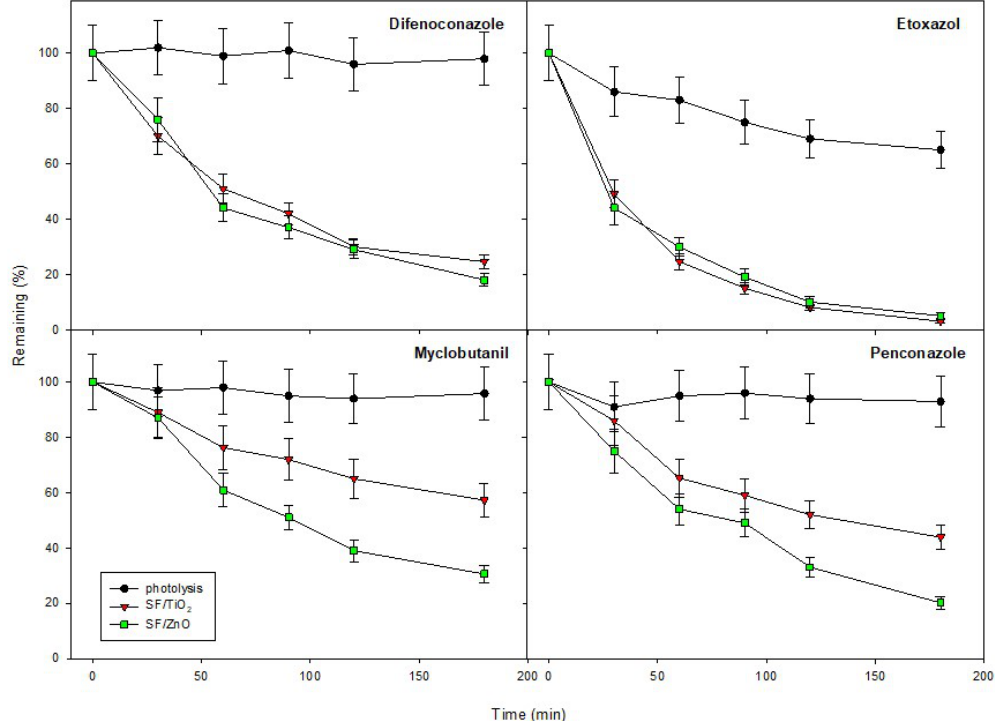
Figure 6. Pesticide decay (0.1 mg L − 1 ) by photolysis and photocatalysis (SF / ZnO and SF / TiO 2 ) during the photoperiod. Approximately 250 mg L −1 of ZnO or TiO 2 in all cases. Error bars denote standard deviation (n = 3).